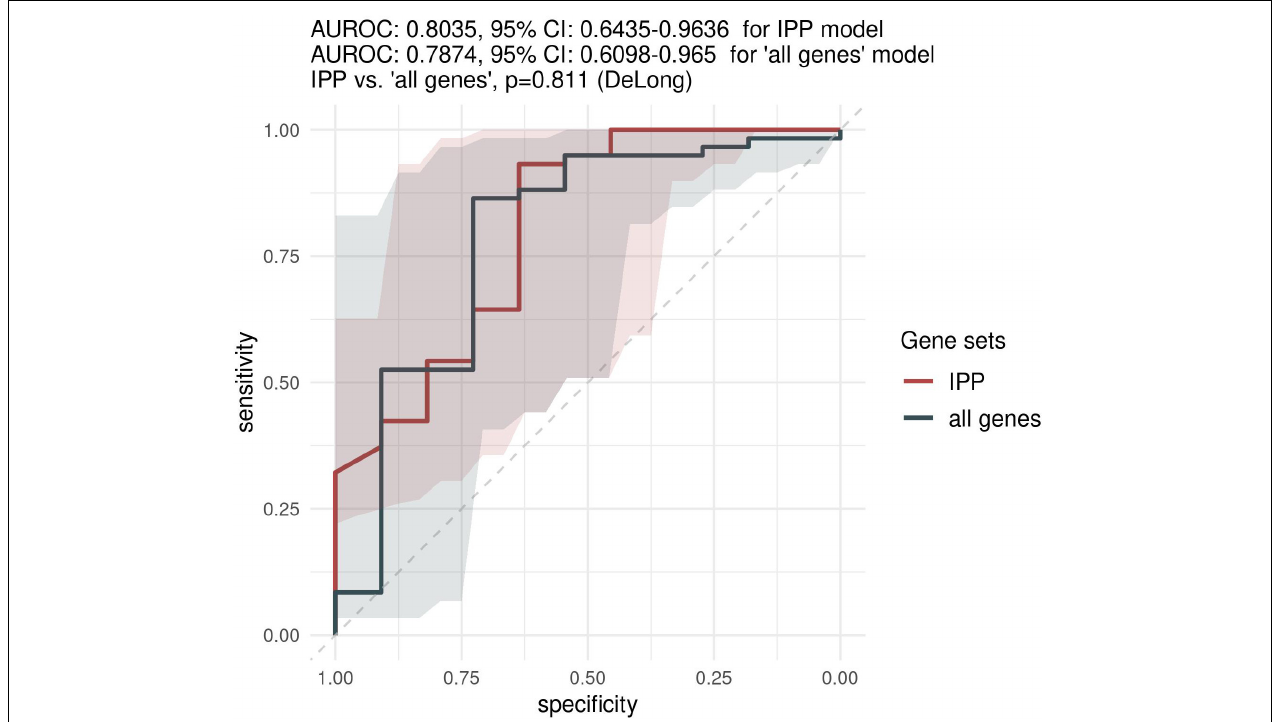
FIGURE 4 | Predictive performance of the IPP gene set on the “days > 2” data set. We assessed the predictive performance of the IPP and “all genes” set by computing ROC curves on the validation set.